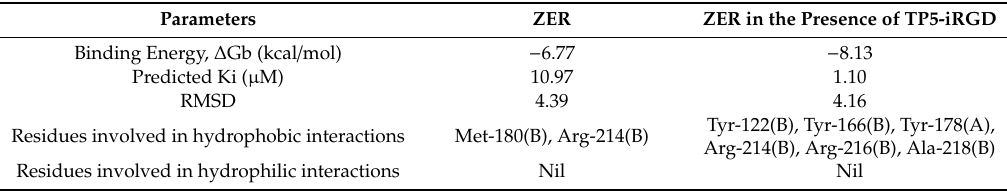
Table 4. Obtained afterdocking of ZER with integrin α v β